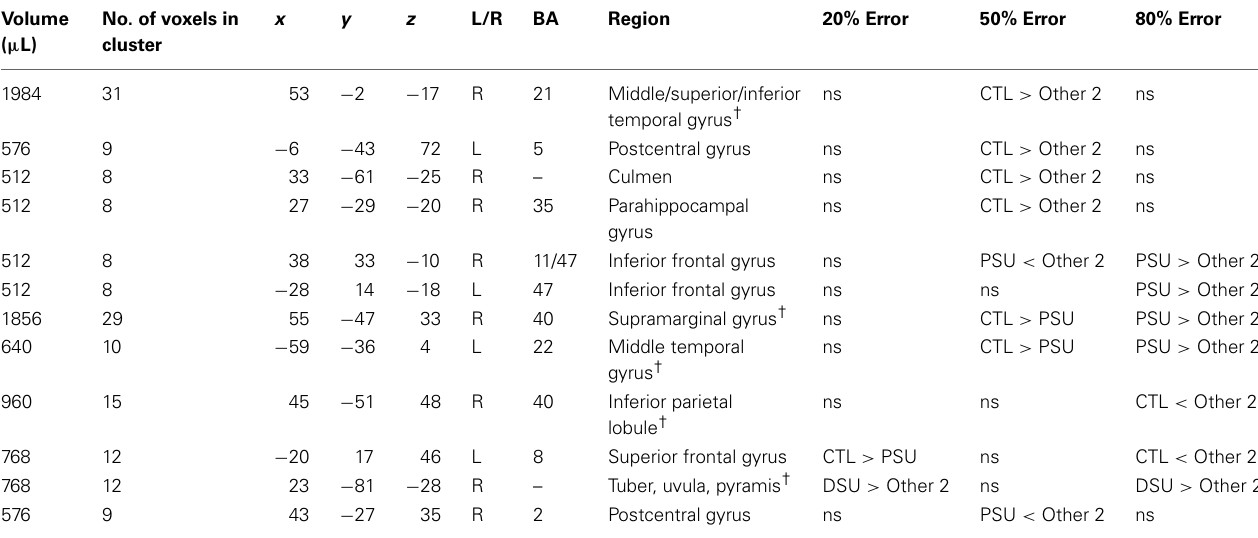
Table 5 | fMRI results for the group by error rate